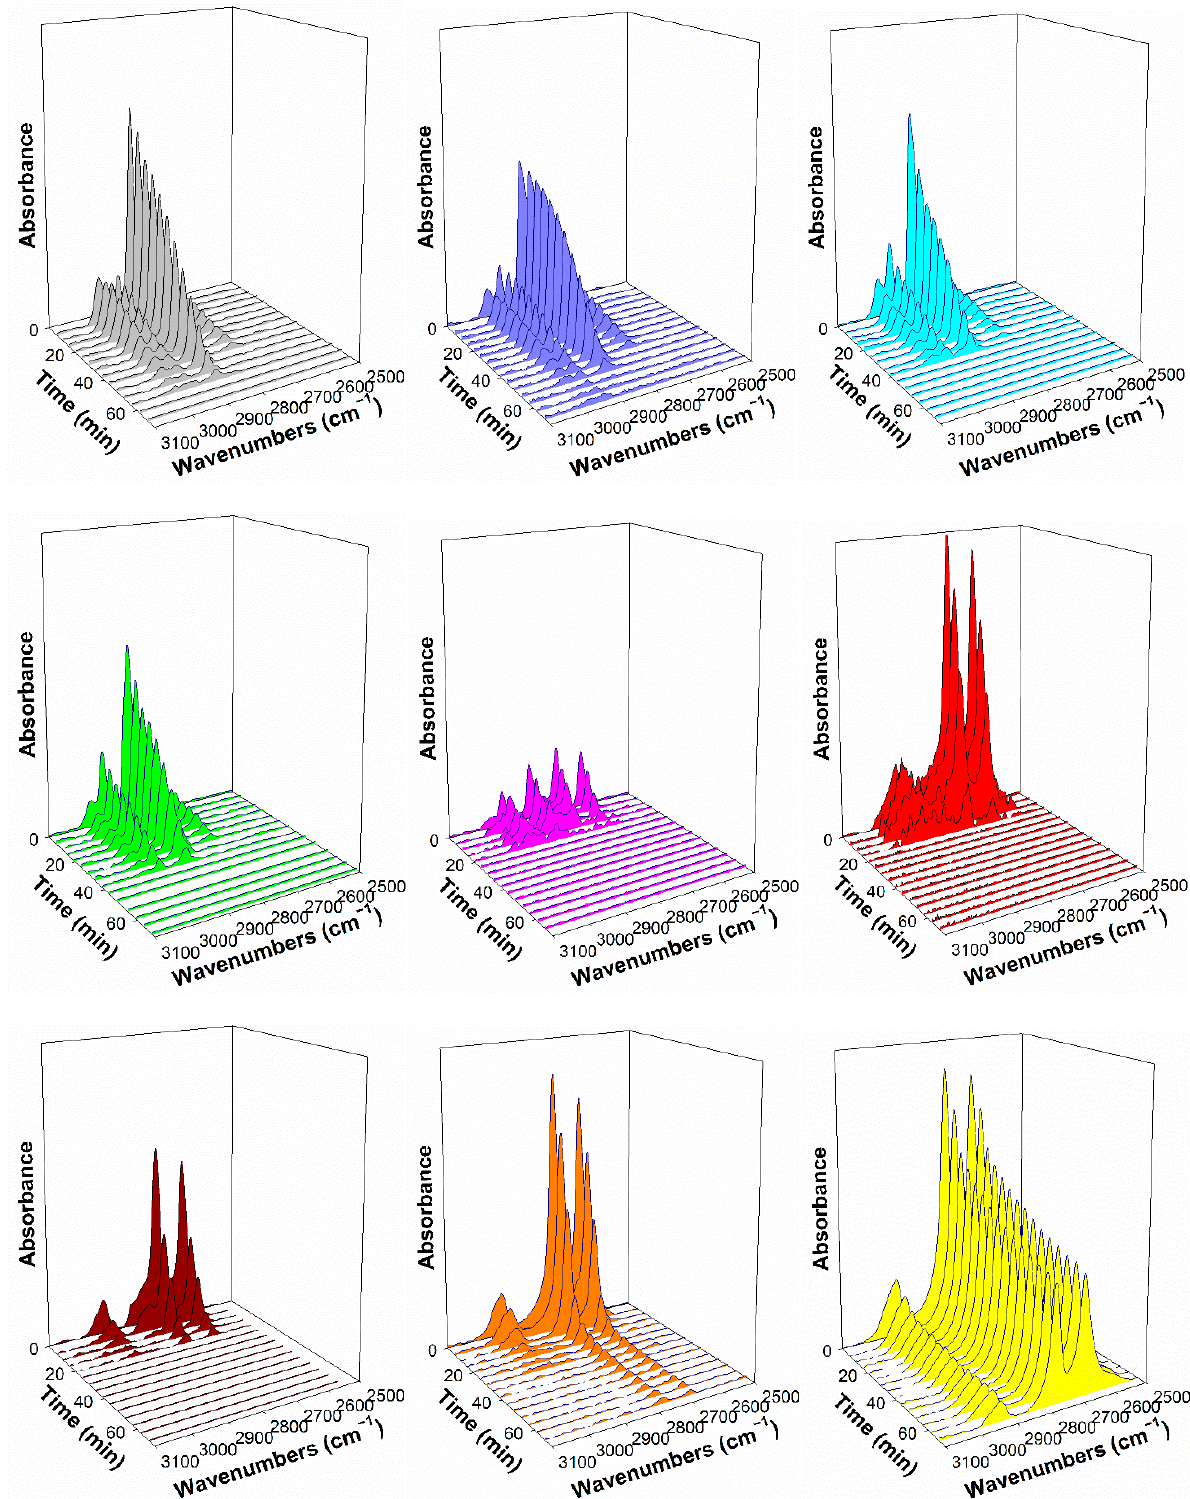
Figure 13. Formate decomposition in steam at 130 °C, where the top 6 catalysts have a maximum y-scale of 0.15, while the bottom 3 catalysts have a maximum at 0.35, including ( gray ) 2%Pt/ZrO 2 , and the same catalyst doped with ( periwinkle ) 0.55%Rb, ( cyan ) 0.93%Rb, ( green ) 1.86%Rb, ( pink ) 2.79%Rb, ( red ) 3.72%Rb, ( dark red ) 4.65%Rb, ( orange ) 5.58%Rb, and ( yellow ) 9.29%Rb.